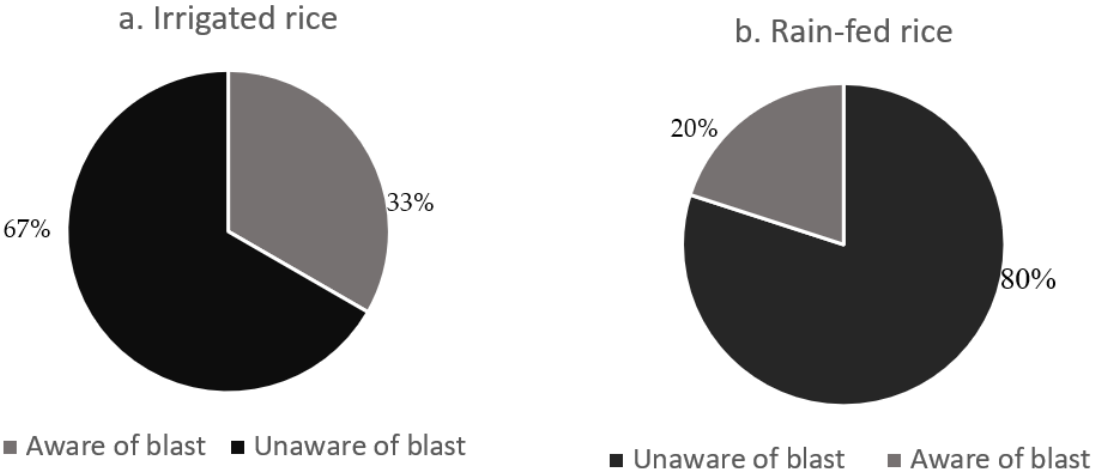
Figure 2. Blast awareness among the rice growers in irrigated and rainfed production systems in Busia and Kisumu counties of Kenya during 2019.